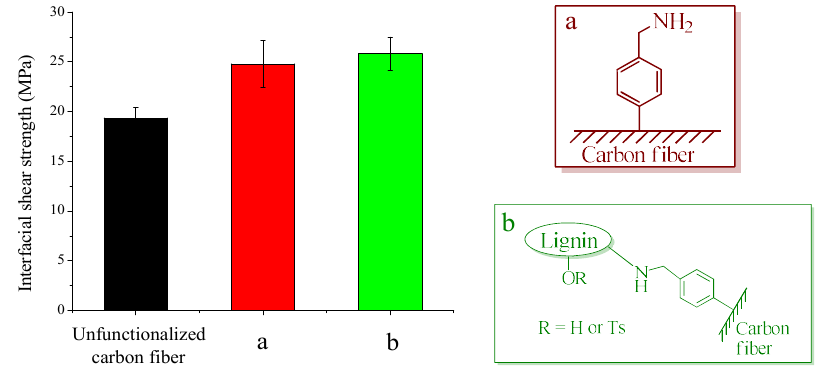
Figure 6. Interfacial shear strength determined indirectly using fragmentation test. The test was performed on composites prepared using cellulose propionate as matrix and unfunctionalized carbon fiber, ( a ) 4-(aminomethyl)benzene functionalized carbon fiber, or ( b ) carbon fiber containing lignin on the surface.